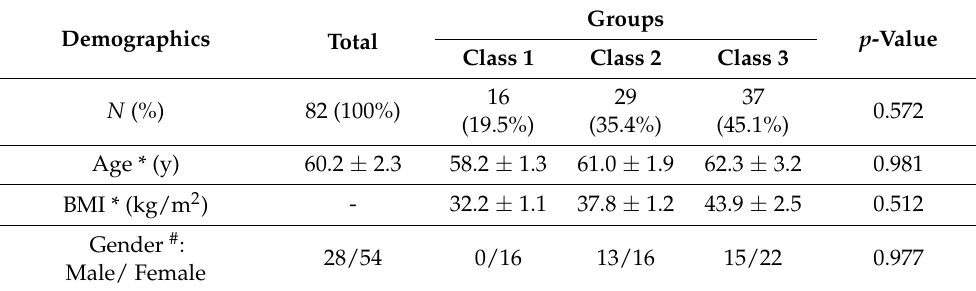
Table 2. Stage 2 of the study—patient demographics.